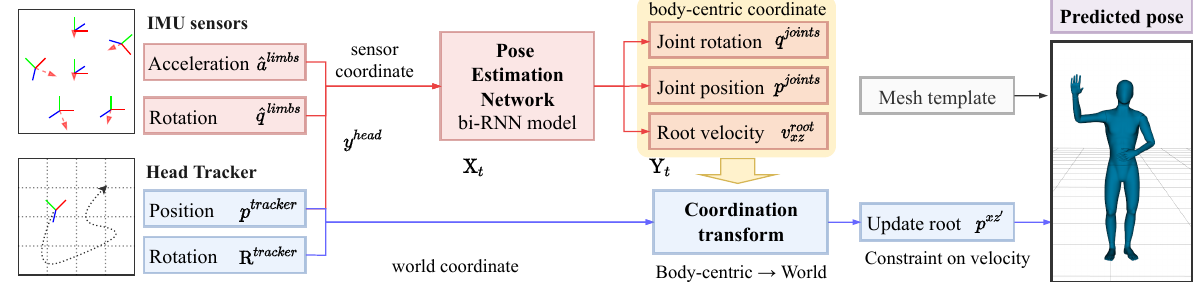
Figure 1. An overview of the proposed method. Our method uses two types of sensors to estimate human poses. IMU sensors are attached to each limb to measure their inertial data (orientation and acceleration), which are then input into the pose estimation network along with the head height to predict the user’s joint position and rotation. By combining global head poses from the head tracker with the joint positions, our method can predict the global full-body pose of the